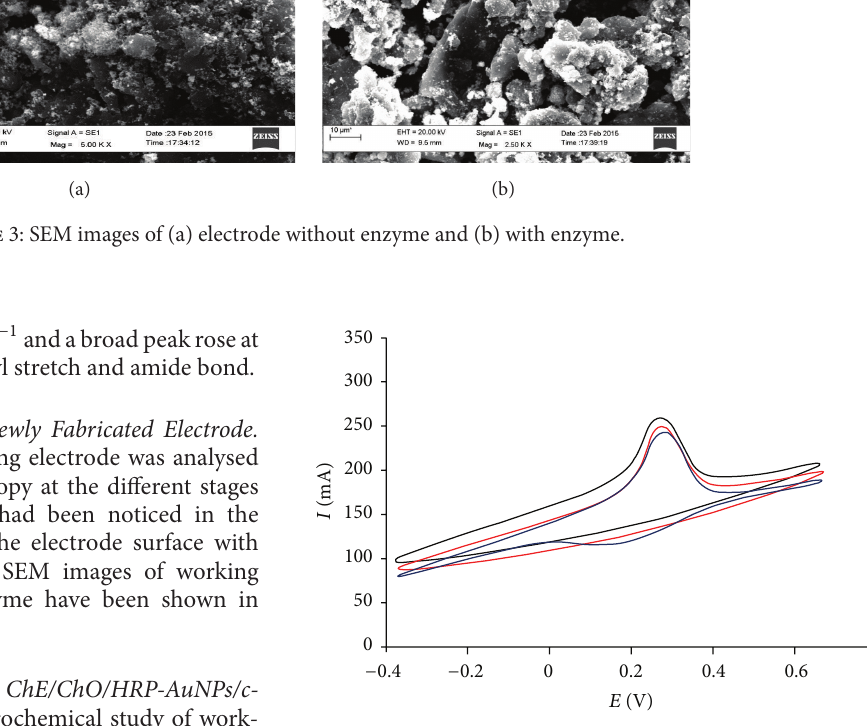
Figure 4: Cyclic voltammogram of ChE/ChO/HRP-AuNPs/c- MWCNTs Ag electrode at various scan rates.